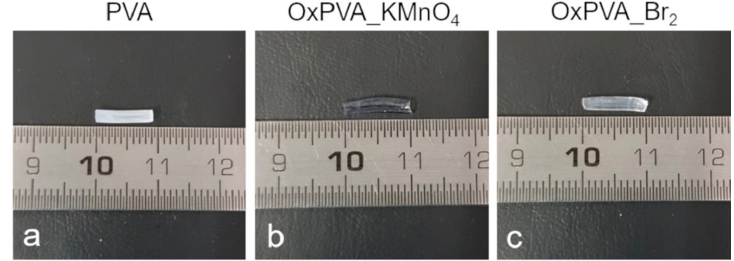
Figure 2. Tubular sca ff olds morphology. Gross appearance of cross-linked PVA ( a ), OxPVA_KMnO 4 ( b ) andOxPVA_Br 2 ( c )nerveguidanceconduitsmanufacturedaccordingtotheinjectionmolding-technique.